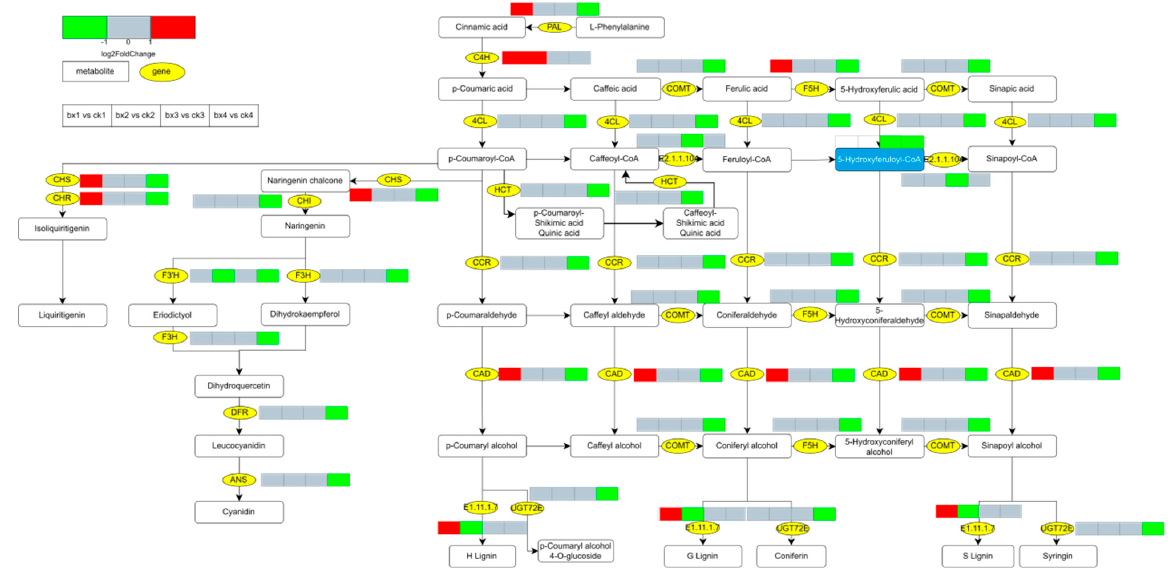
Figure 11. Expression pro fi les of genes and metabolites involved in ‘Phenylpropanoid biosynthesis’, ‘Flavonoid biosynthesis’ and ‘Stilbenoid, diarylheptanoid and gingerol biosynthesis’. The yellow oval pa tt ern represents the gene and rounded rectangles represent metabolites. Metabolites in blue box were annotated and metabolites in white font were annotated. Four continuous boxes indicate the di ff erent fold changes of DEGs or DMs in bx1 vs. ck1; bx2 vs. ck2; bx3 vs. ck3; and bx4 vs. ck4, respectively. Red indicates up-regulated (log 2 foldchange > 1), green indicates down-regulated (log 2 foldchange < − 1), grey indicates no signi fi cant change ( − 1 ≤ log2foldchange ≤ 1), and white indicates the metabolites or genes that were not annotated. 4CL, 4-coumarate: CoA ligase; PAL, Phenylalanine ammonia lyase; CAD, Cinnamoyl alcohol dehydrogenase; C4H, Cinnamic acid 4-hydroxylase; CHS, Chalcone synthase; CHR, Chalcone reductase; CHI, CHS-chalcone isomerase; HCT, hydroxycinnamoyl transferase; DFR, dihydro fl avonol 4-reductase; CCR, cinnamoyl CoA reductase; HCT, shikimate hydroxycinnamoyl transferase; F3H, fl avanone 3 hydroxylase; F3 ′ H, fl avanone 3 ′ - hydroxylase; F5H, fl avanone 5 hydroxylase; COMT, ca ff eic acid O-methyltransferase; ANS , anthocyanidin synthase.